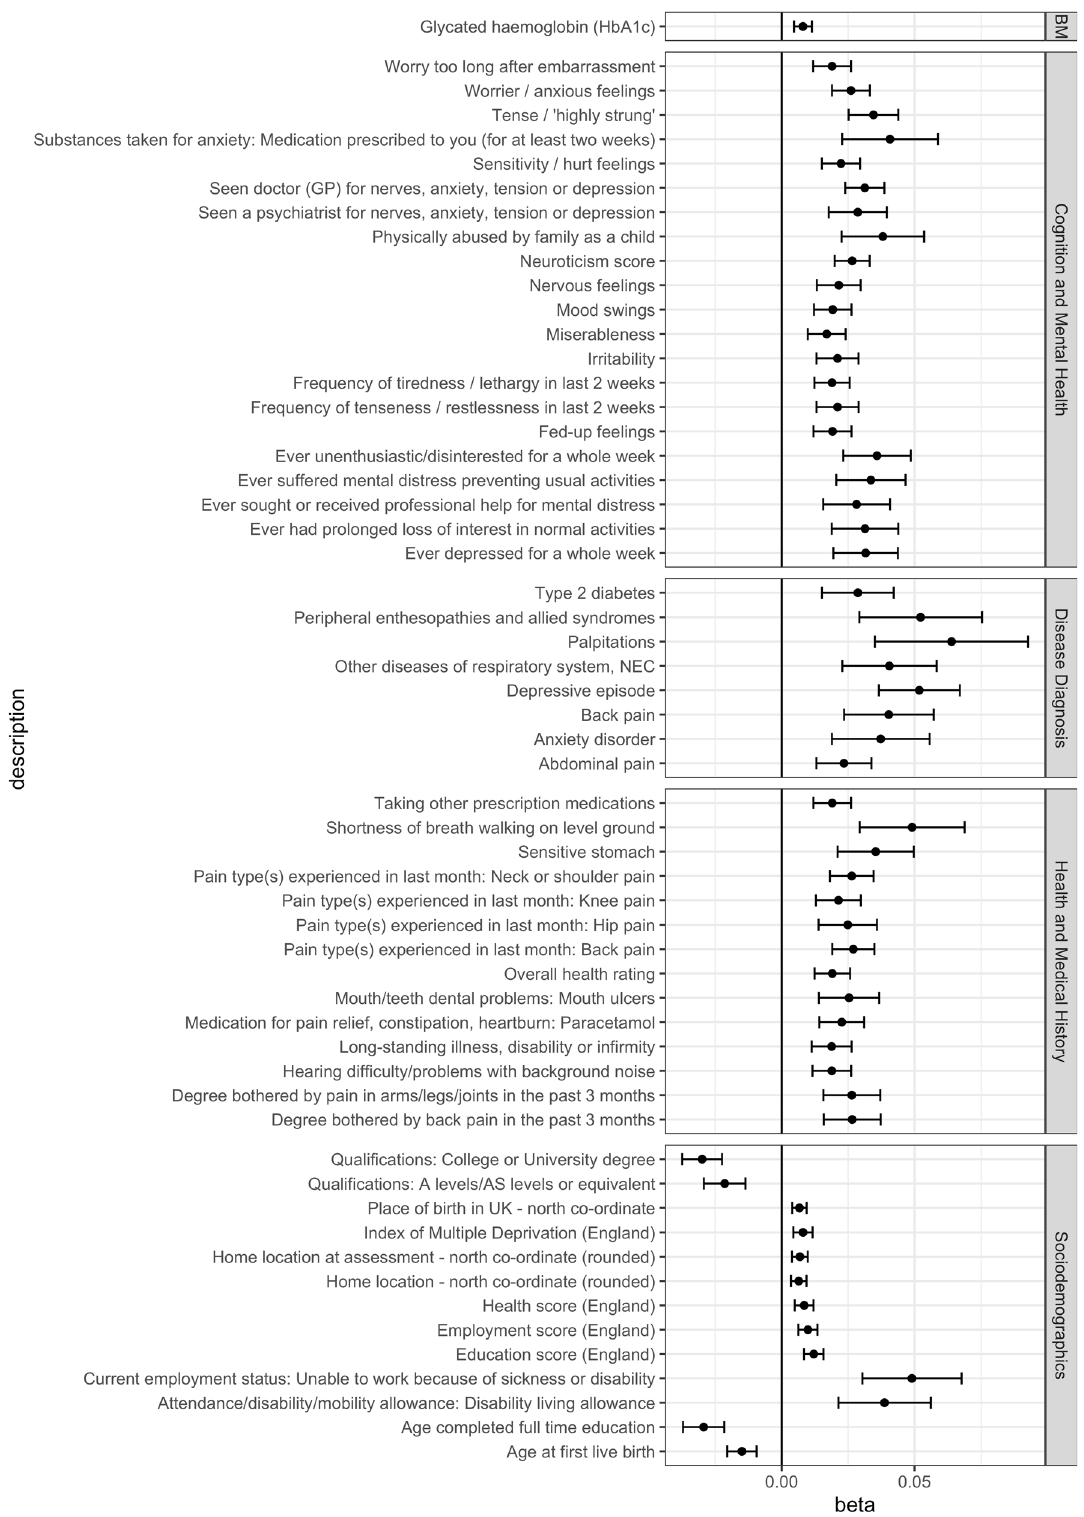
Fig. 3 Forest plot showing phenotypes signi fi cantly associated with TS PRS, grouped by categories. The x-axis shows the (Beta) effect size for each phenotype estimated by PheWAS. BM Biochemical TS PRS (beta: − 0.017, p -value: 3.7 × 10 − 3 ). Biochemical mea- sures such as IGF1 and eosinophil count were also negatively associated with the risk of TS (beta: − 0.005 to − 0.008, p -value: 3.5 × 10 − 3 – 3.8 × 10 − 5 ).